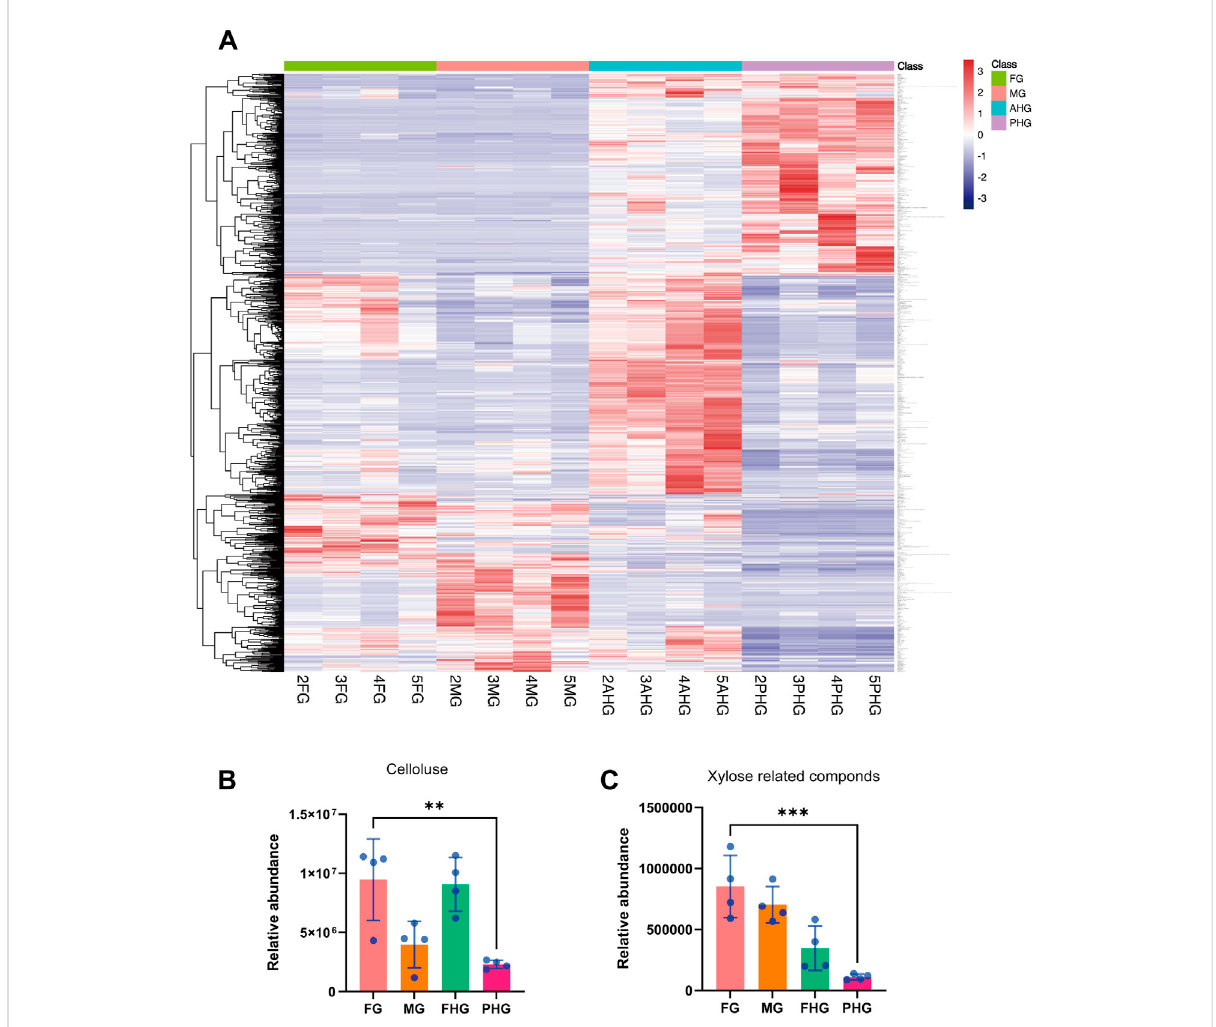
FIGURE 3 Comparison of featured metabolites in four gut segments of A. swainsoni larvae. (A) Heatmap of statistical differential metabolites of four gut segments. A total of 1,026 statistically differential metabolites were selected on the basis of the combination of a threshold of variable in fl uence on projection values and p values from atwo-tailed Student ’ s t -test on thenormalized peak areas. (B) Comparison of relative abundance of cellulose of four gut segments. (C) Comparison of relative abundance of xylose-related compounds of four gut segments. The ** indicates .001 < p ≤ .01, and the *** indicates p ≤